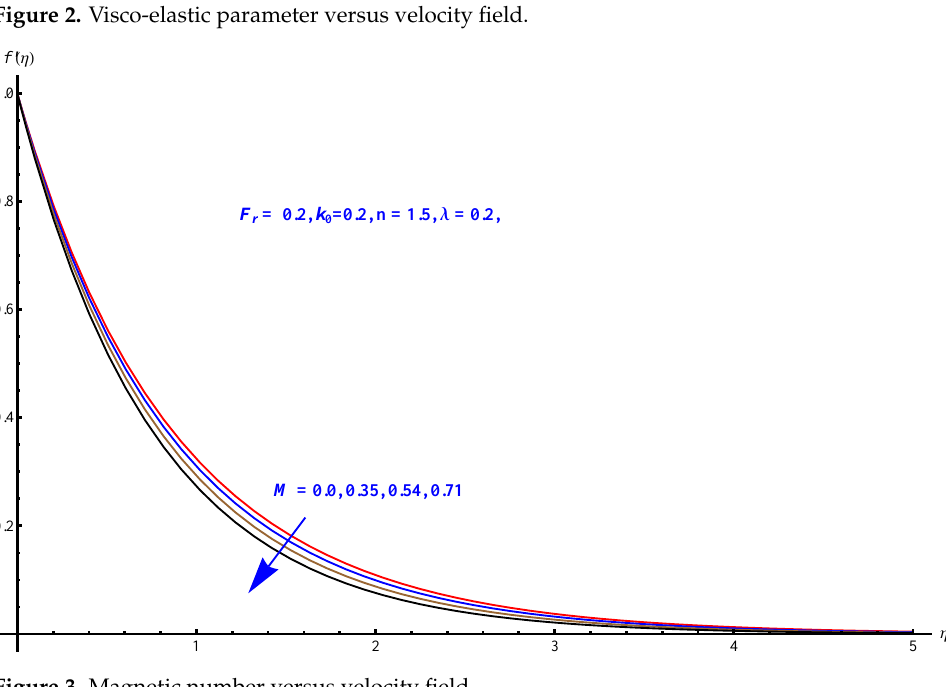
Figure 3. Magnetic number versus velocity